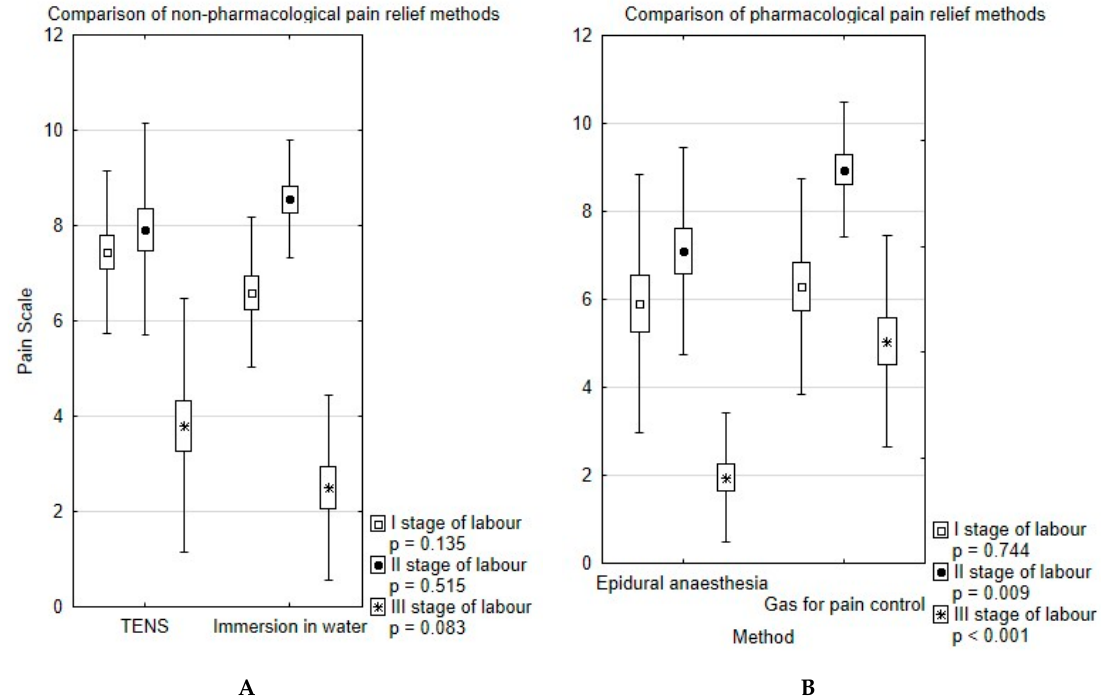
Figure 2. Comparison of non-pharmacological ( A ) and pharmacological ( B ) pain relief methods.